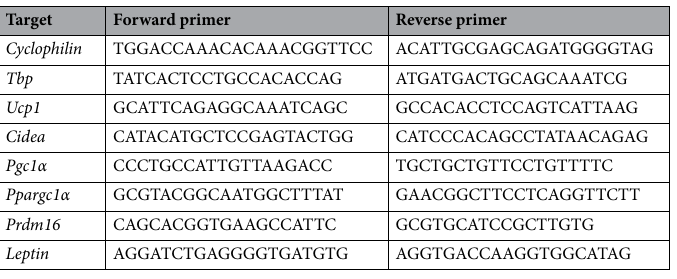
Table 1. Primer sequences used for